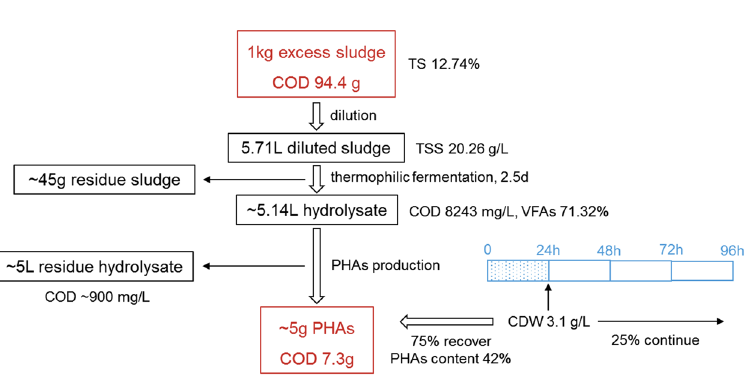
Figure 5. The overall process and efficiency of PHA production with valerate-dominant sludge hydrolysate in conversion of 1 kg excess sludge into